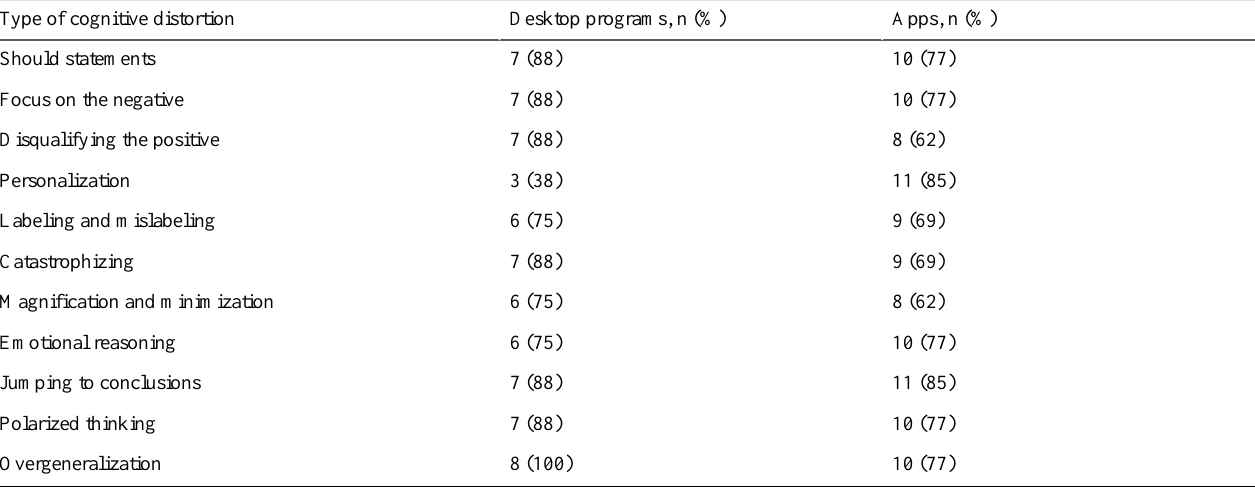
Table 6. Absolute numbers and relative share of web-based interventions addressing cognitive distortions for desktop programs (N=8) and apps